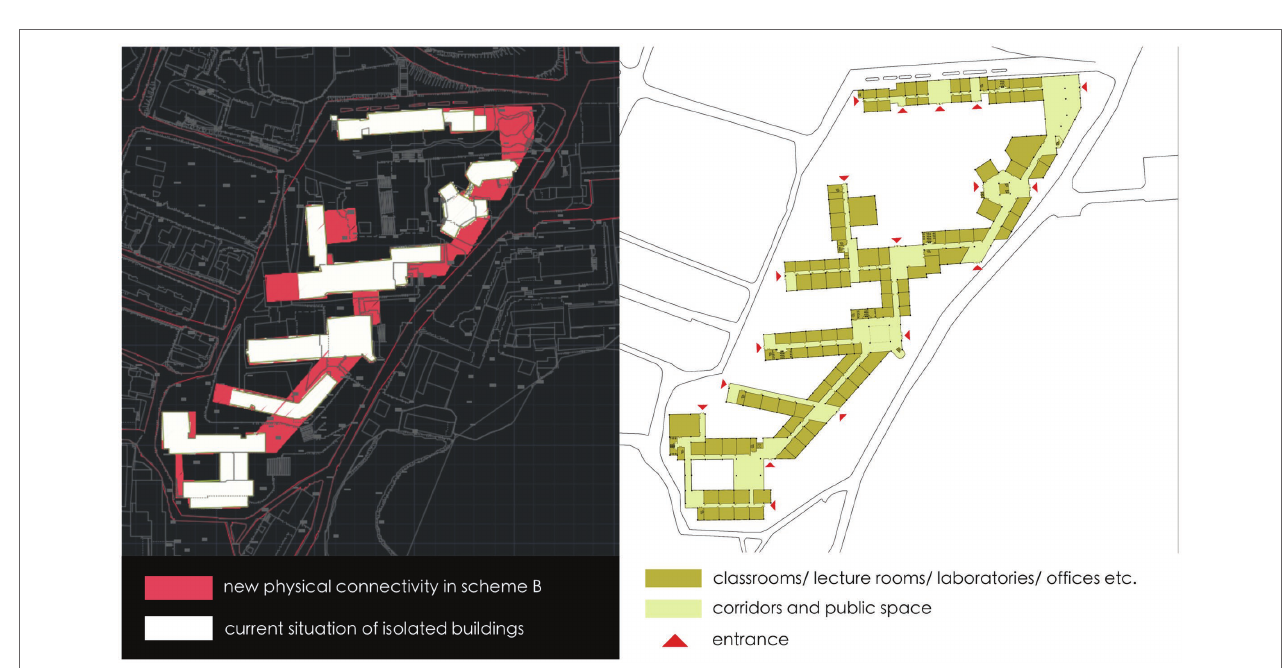
FIGURE 7 | The plan of scheme B which connects isolated buildings on one